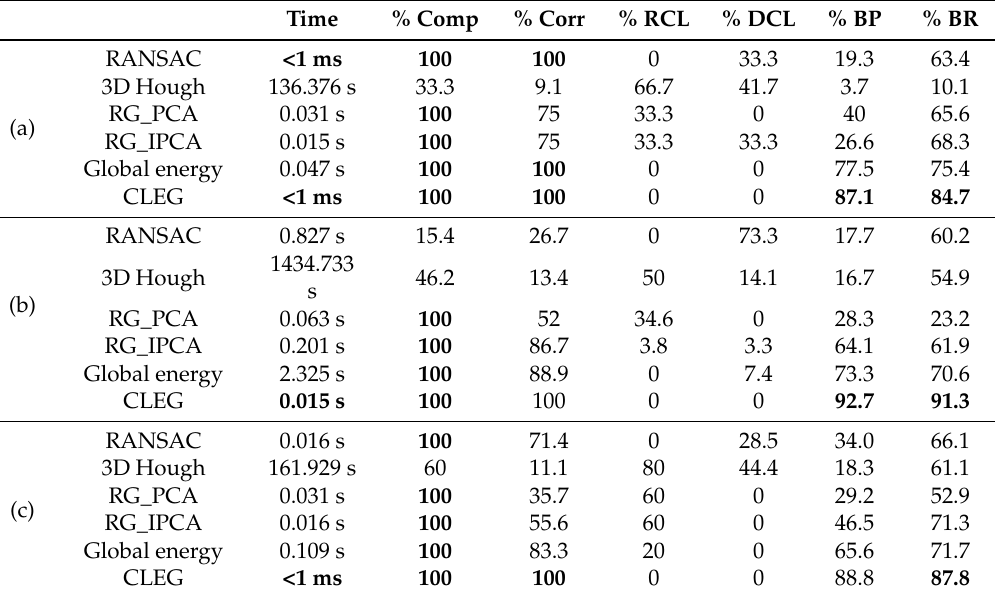
Table 4. Quality of segmentation results in the Wuhan